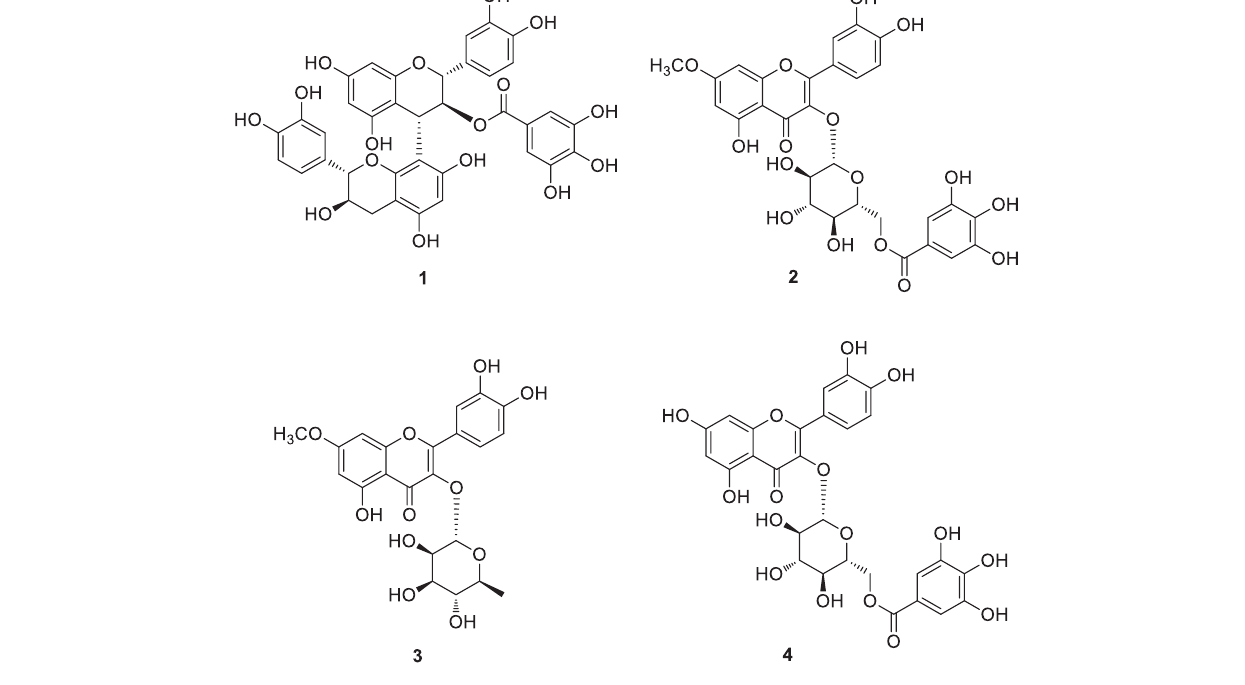
FIGURE 2 | Chemical structures of compounds 1–4 .